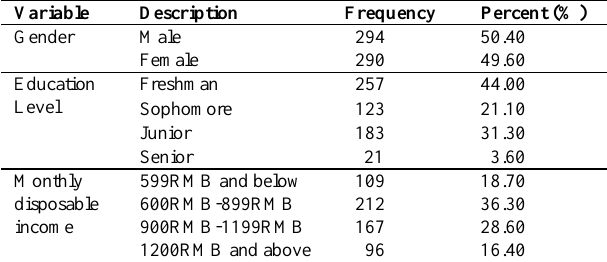
Table 1: Demographic profile of the